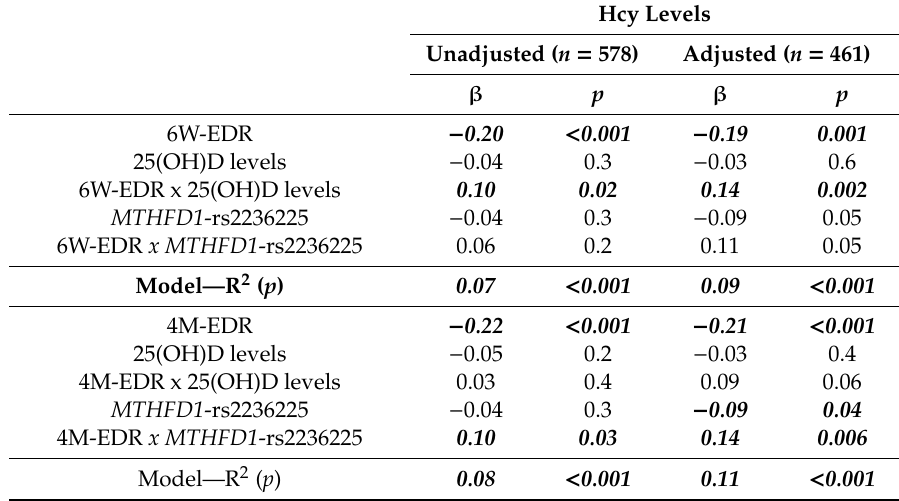
Table 6. Independent and interactive influences of EDR measures, 25(OH)D levels and MTHFD1 -rs2236225 on Hcy levels.